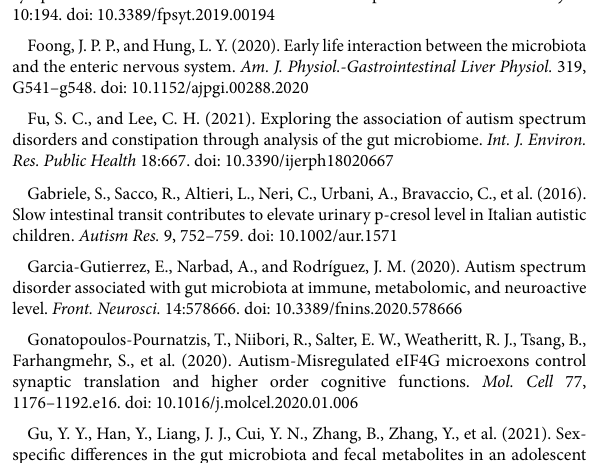
SUPPLEMENTARY FIGURE S1 Alpha diversity analysis (n=8 per group). (A) Pielou index and (B) Simpson